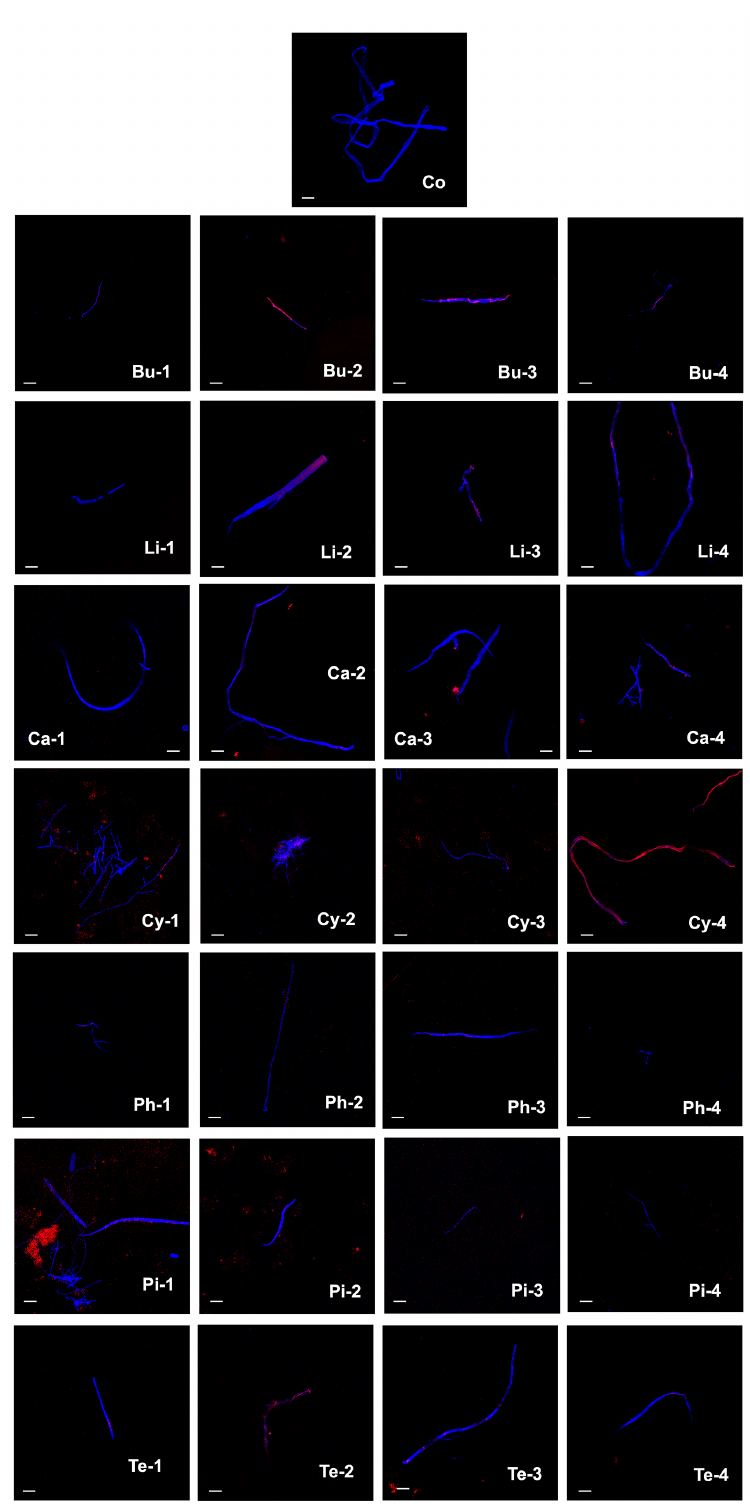
Figure 2. Effect of essential oils and five pure compounds on the mycelium of Fusarium solani . Microphotographs were obtained by fluorescence microscopy and dyed with calcofluor-white ( L = 450 nm) and propidium iodide ( L = 580 nm) at a total magnification of 100. The scale-bar represents 50 µ m. Control (Co), Bursera morelensis essential oil (Bu), Lippia graveolens essential oil (Li), carvacrol (Ca), p -Cymene (Cy), α -phellandrene (Ph), α -pinene (Pi), and Υ -terpinene (Te). The numbers correspond to the concentration of 2.0 µ L/mL at 4 h (1) and at 48 h (2) of exposure and at the concentration of 4.0 µ L/mL at 4 h (3) and at 48 h (4) of